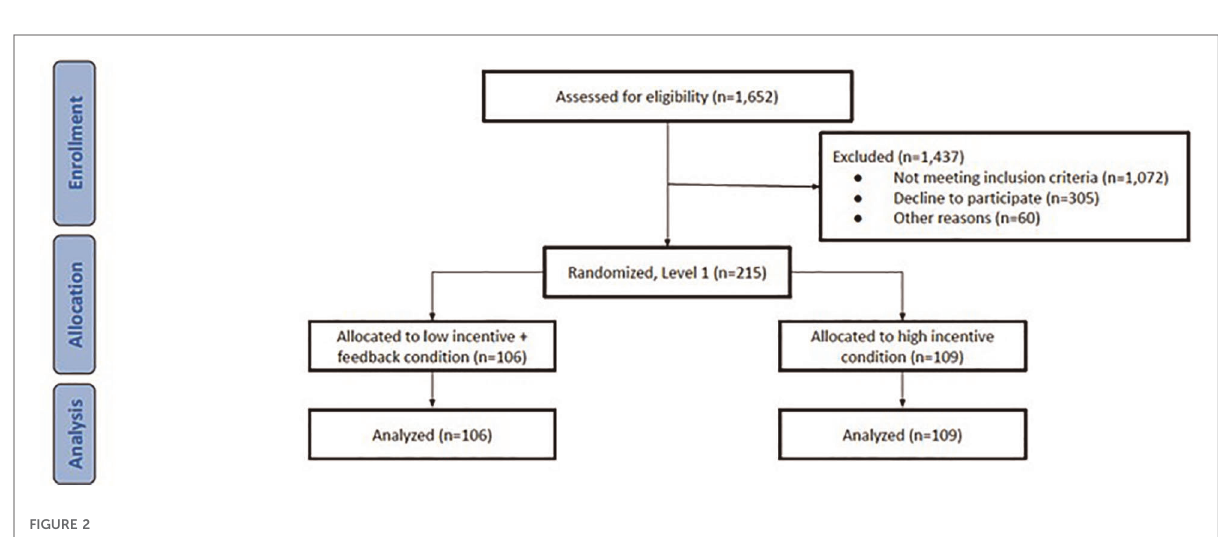
FIGURE 2 CONSORT Table for incentive condition